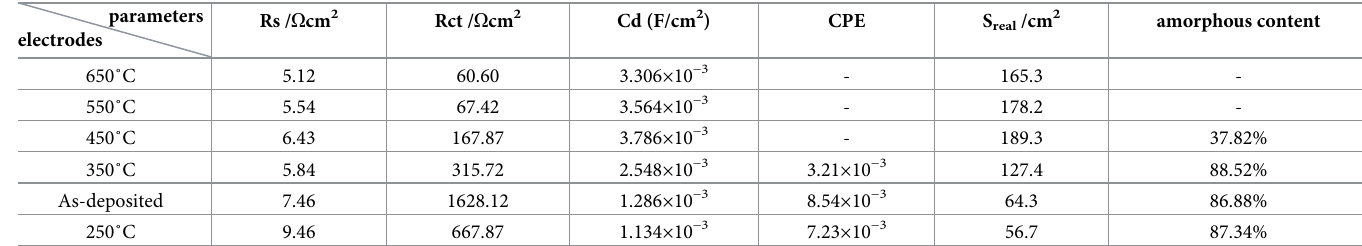
Table 3. Equivalent circuit parameters of the various components for as-deposited and heat-treated samples. parameters electrodes